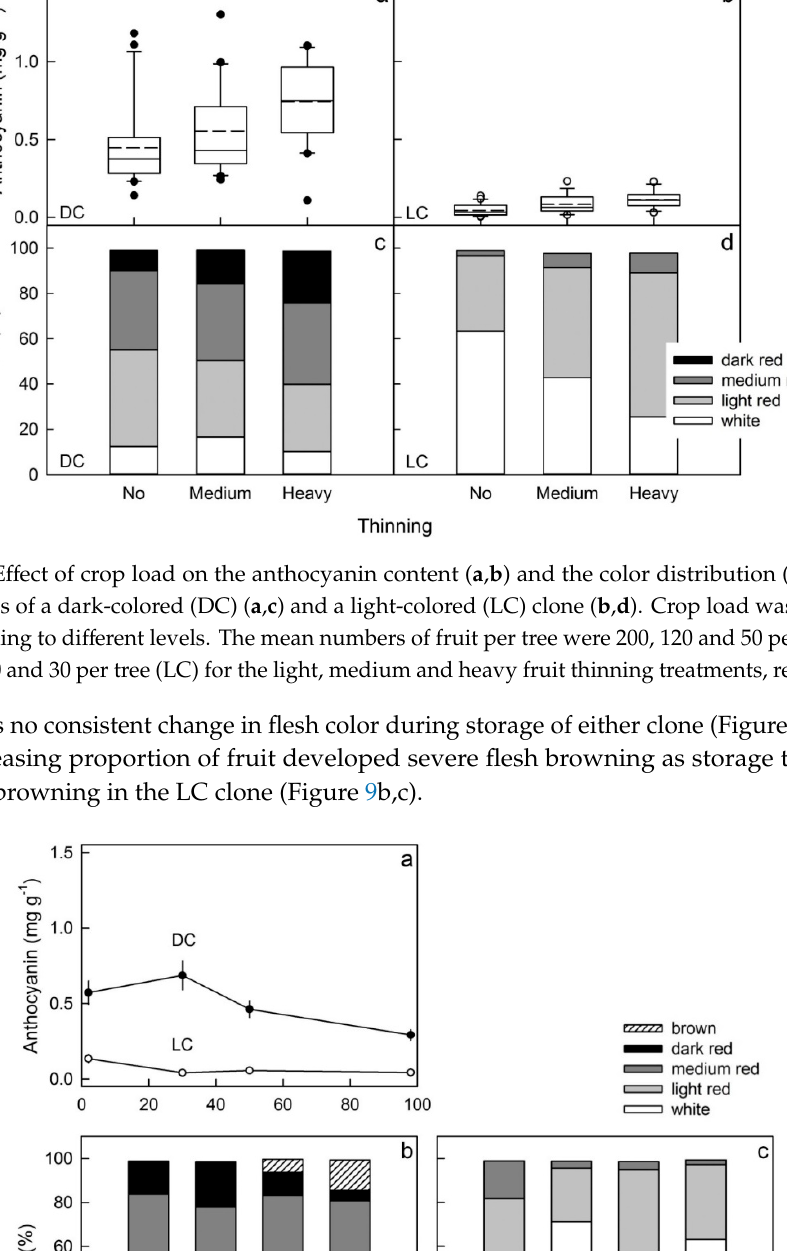
Figure 7. Effect of UV radiation on the anthocyanin content ( a , b ) and the color distribution ( c , d ) of red flesh apples of a dark-colored (DC) ( a,c ) and a light-colored (LC) clone ( b,d ). UV radiation was excluded by wrapping the fruit in a bag made of UV-absorbing film. The film absorbed 100% of the UV radiation. Fruit that was exposed to full sunlight served as control.